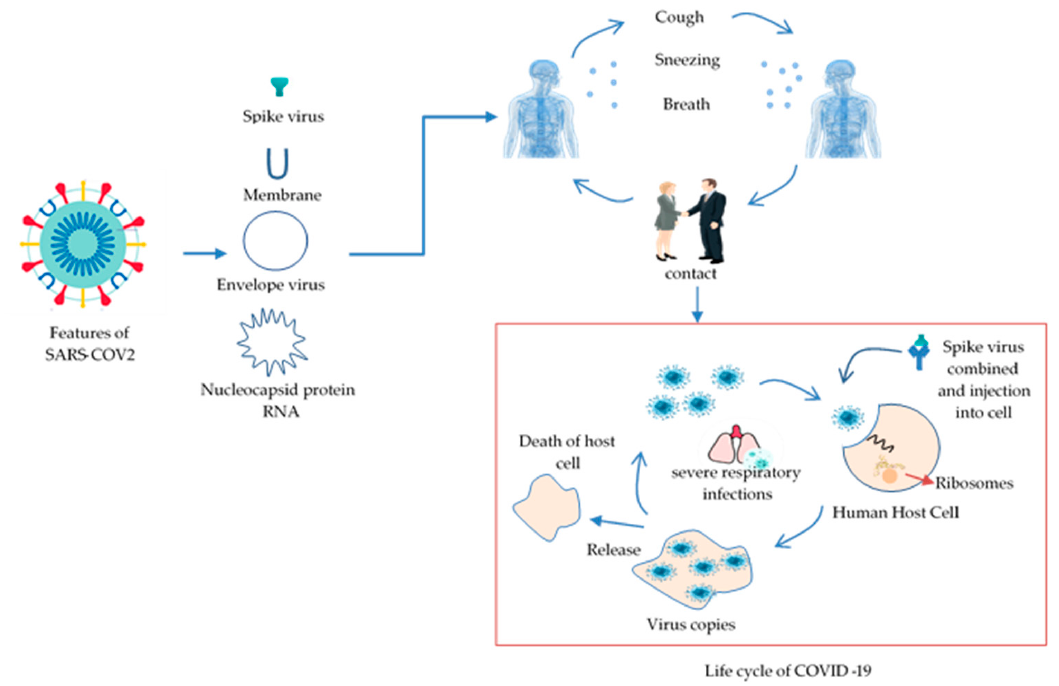
Figure 1. Illustration of the feature shape of COVID-19 and the transportation cycle to the lungs of humans.